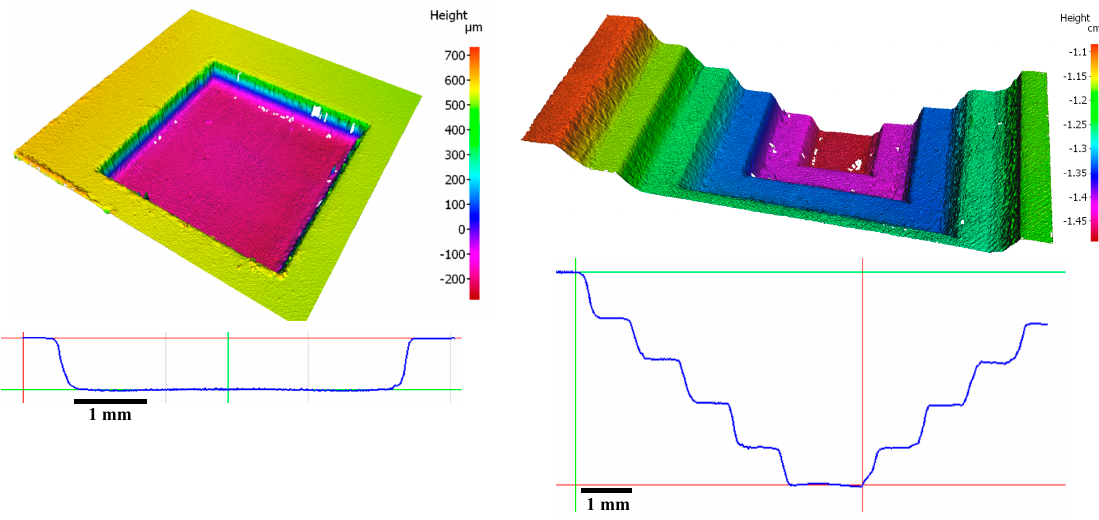
Figure 14. Morphology of high-quality constant depth area engraving ( a ) 13 mm 3 / min MRR at 1.4 µ m S a using: Engraving pass at 4.2 J / mm 2 , 380 ns, 175 kHz; Cleaning pass at 150 ns, 350 kHz, 3.5 J / mm 2 and polishing pass at 1.82 J / mm 2 , 500 ns, 500 kHz using IM and halftone scanning. ( b ) Inverted stepped pyramid-shaped engraving.